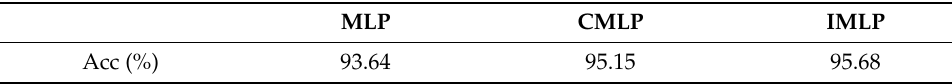
Table 7. Accuracy results (%) of IMLP VS. MLP/CMLP.